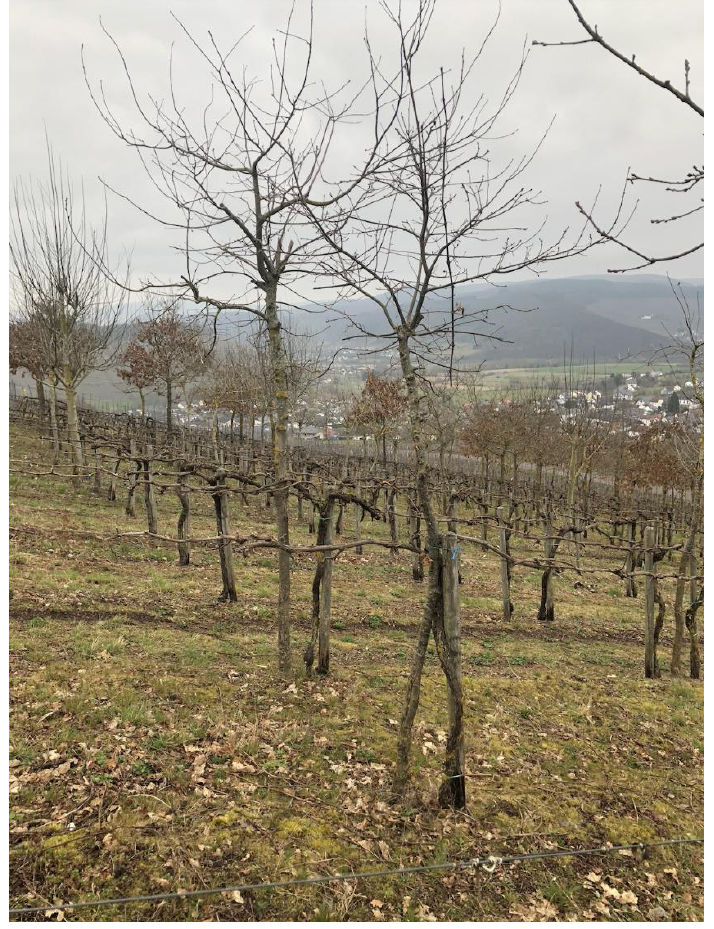
Figure 2. Author’s photography of the agroforestry vineyard.